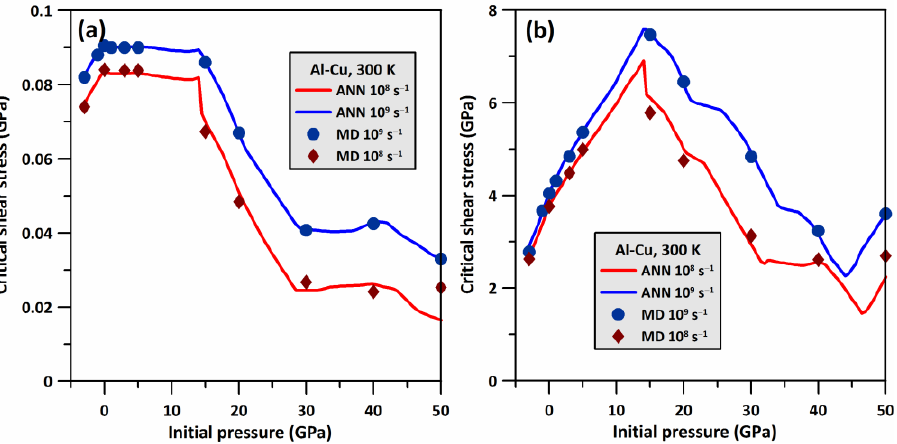
Figure 14. Comparison of the ANN and MD: pressure dependencies of ( a ) critical shear strain and ( b ) critical shear stress of the plasticity initiation in the Al-Cu bisystem at two strain rates, 10 8 and 10 9 s − 1 .